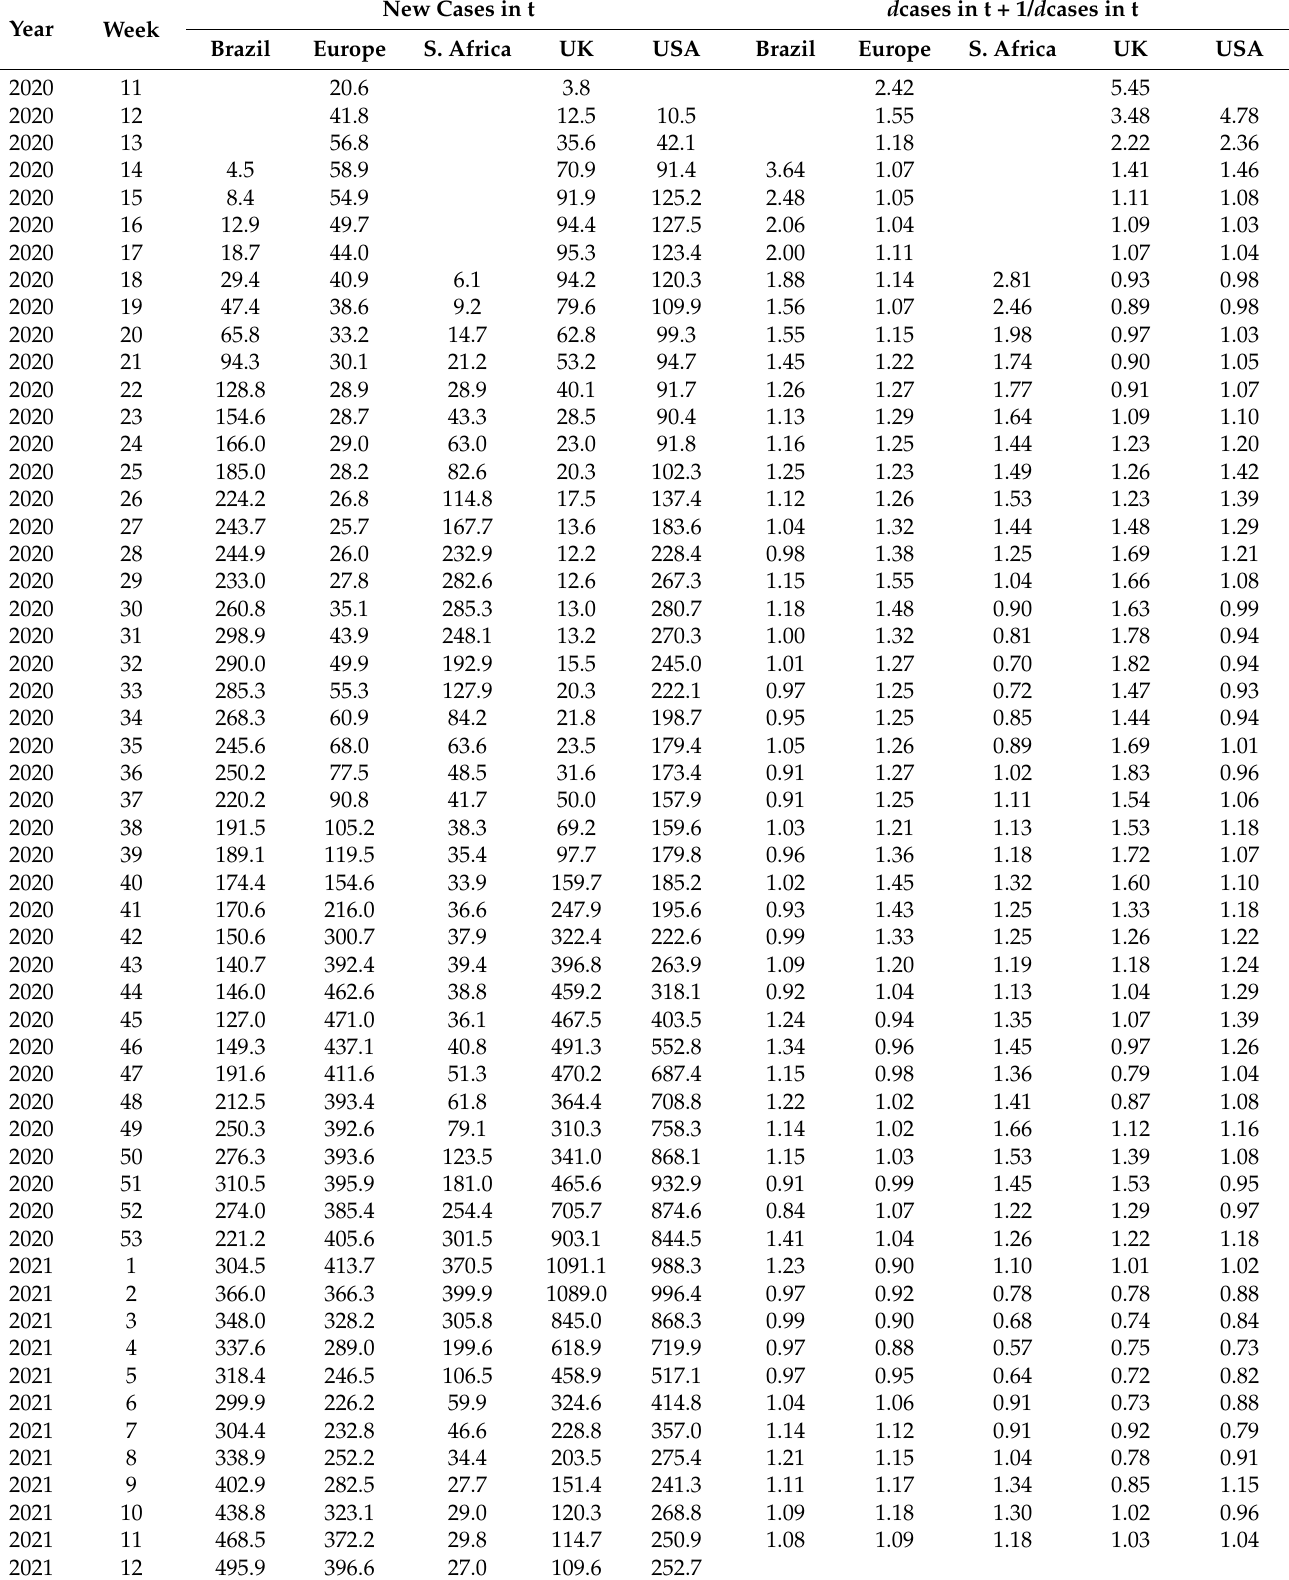
Table 2. The COVID-19 data and empirical